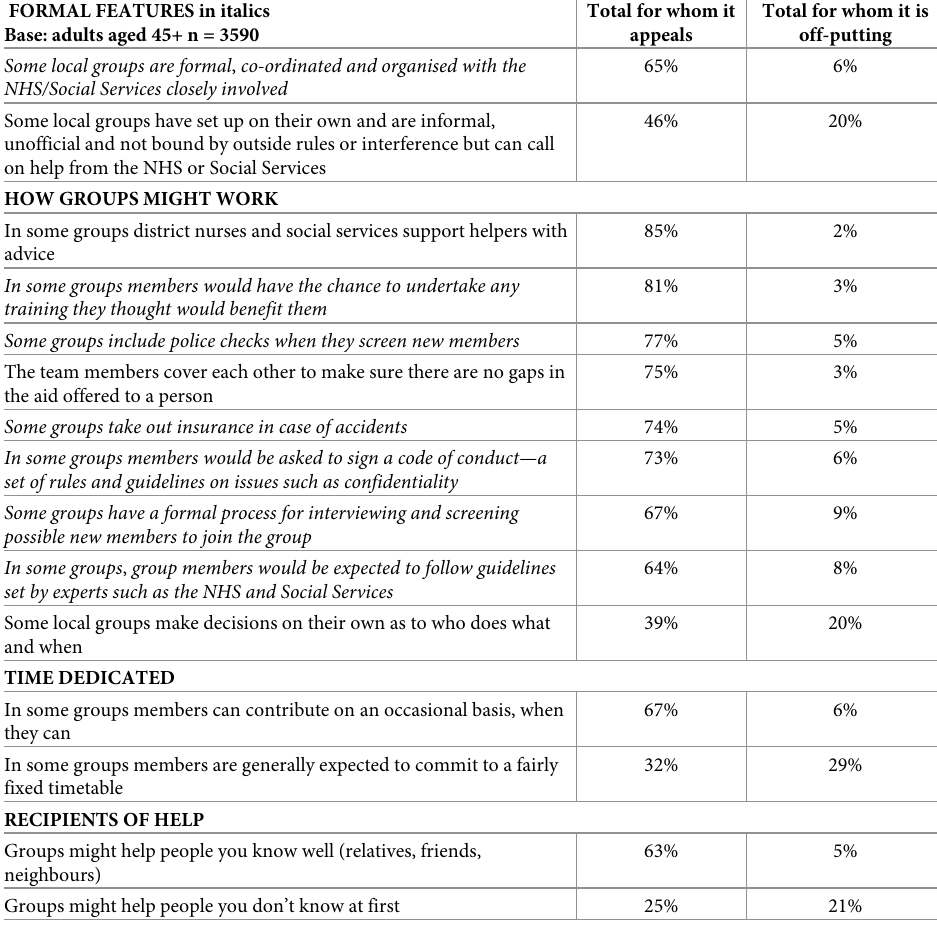
Table 4. Appeal of features of a local group helping the elderly. FORMAL FEATURES in italics Base: adults aged 45+ n = 3590